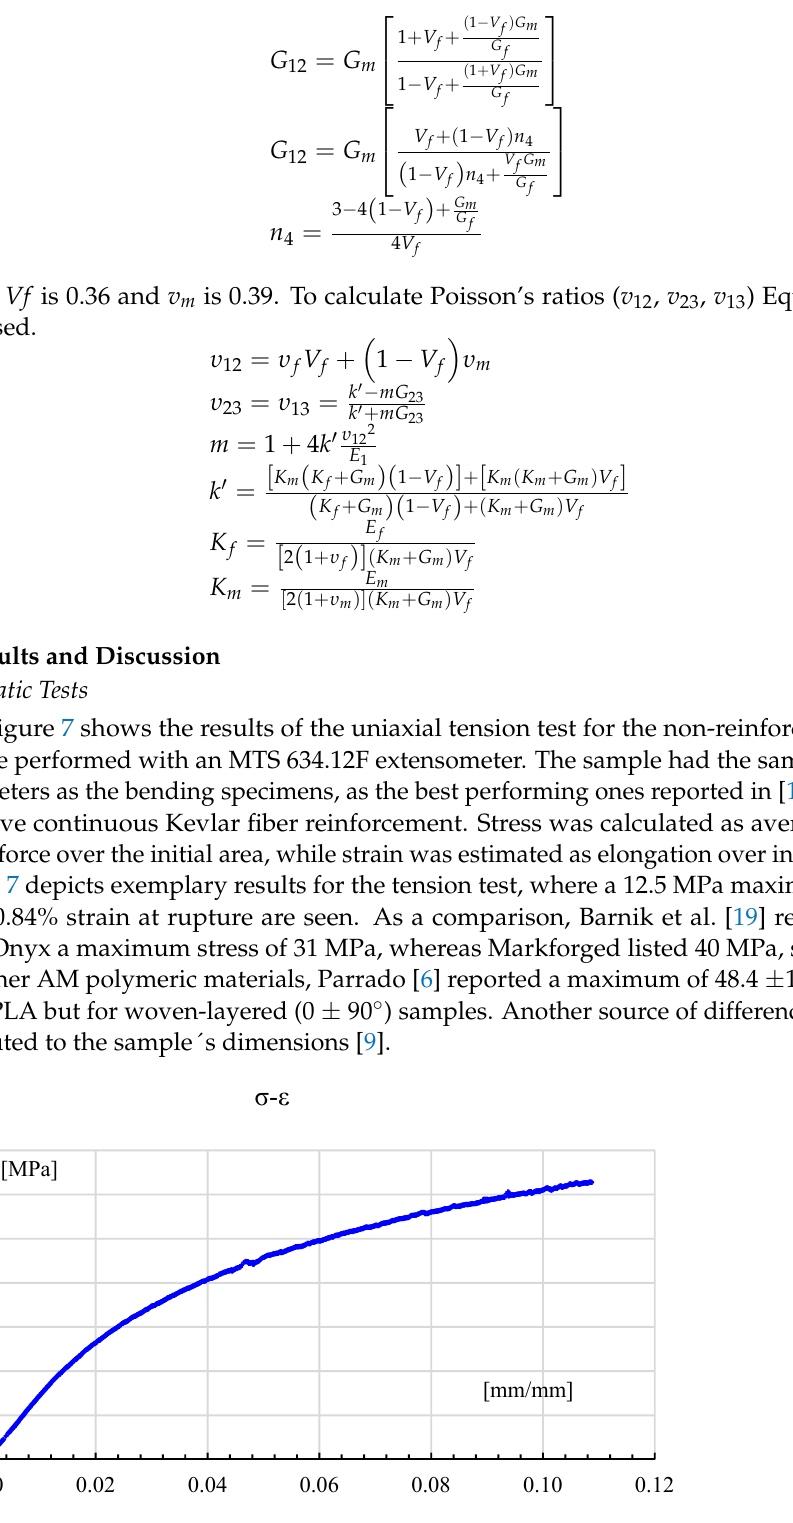
Figure 7. Stress-strain plot in axial tension for a non-reinforced Onyx ® sample.